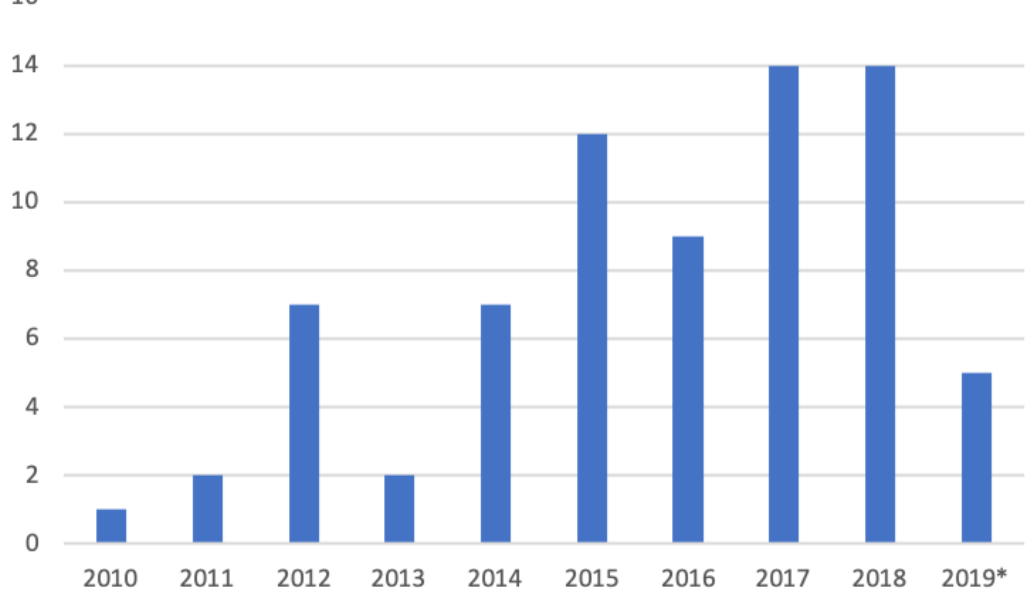
Figure 2. Number of articles per year. * only the articles published prior to 24 April 2019 are